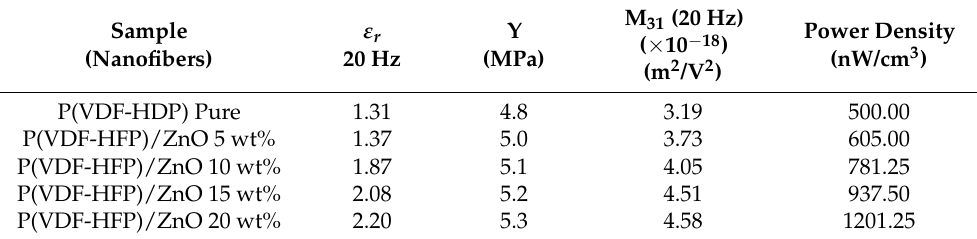
Table 3. The dielectric constant ( ε r ), the Young’s modulus (Y), the M 31 electrostrictive coefficient, and the power density for the synthesized P(VDF-HFP)/ZnO composites nanofibers, shown with P(VDF-TrFE-CFE) composites films included for